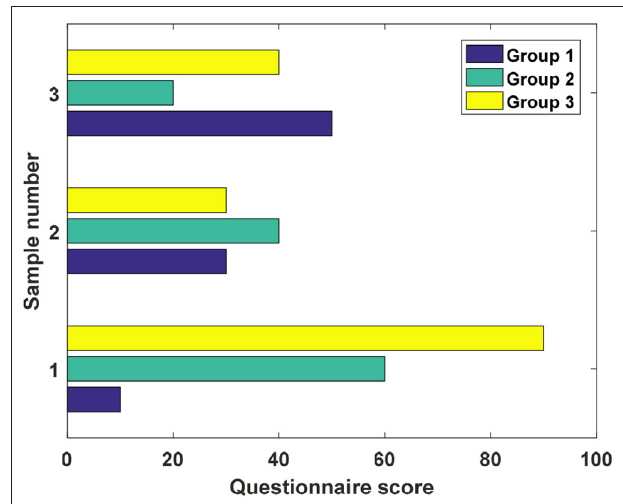
FIGURE 3 | Histogram of cognitive ability scores of left-behind children in rural areas.